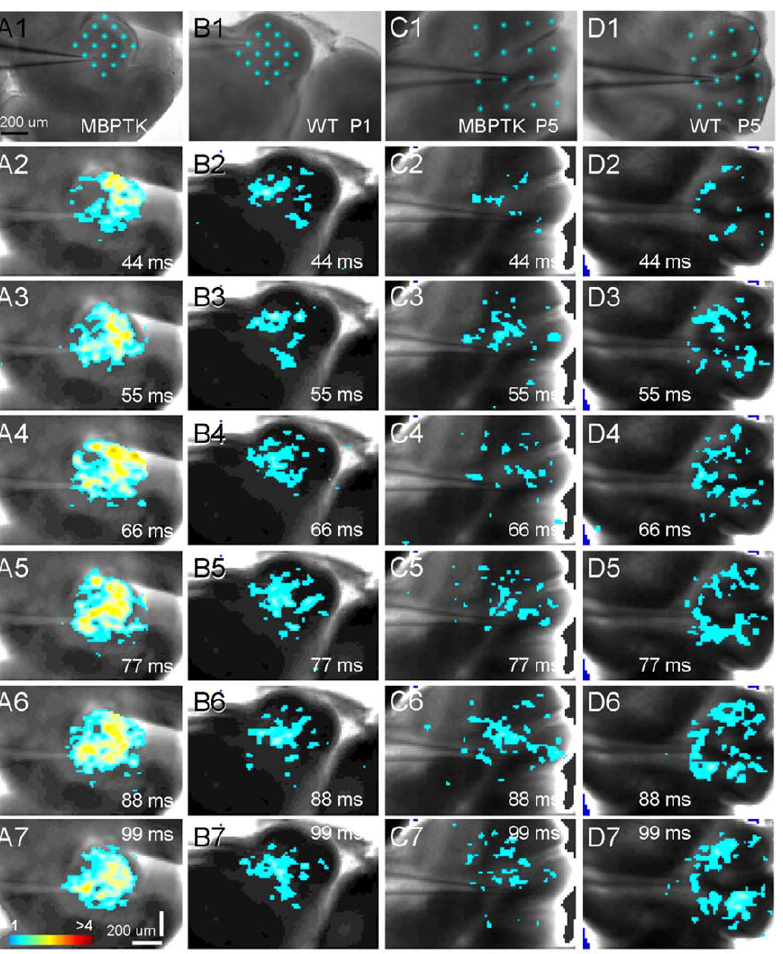
Figure 6. Neuronal population responses in WT and MBP-TK treated cerebellar cortical slices. (A, B) VSD image frames in response to multiple site photostimulation (laser duration: 2 ms; power: 20–24 mW) in WT and MBP-TK treated cerebellar cortical slices (P1), respectively. These image frames are pooled from the image data of all photostimulation sites, as indicated in the reference images. Time progresses from top to bottom in the column, and color code is used to indicate VSD signal amplitudes expressed as standard deviations (SD) above the mean baseline. Similarly, C and D are the VSD image frames in response to multiple site photostimulation (laser duration: 2 ms; power: 20–24 mW) in the wild type and MBP-TK treated cerebellar cortical slices (P5), respectively. MBP-TK treated slices exhibited overall higher excitability in P1–P2 than P4–P5, as reflected by stronger evoked VSD responses. WT slices tended to have a more similar excitability across P1–P5.